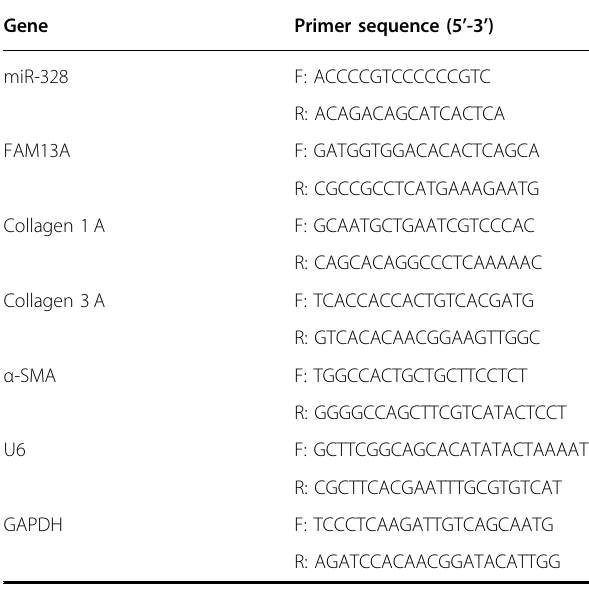
Table 1 Primer sequences for RT-qPCR Gene Primer sequence (5 ’ -3 ’